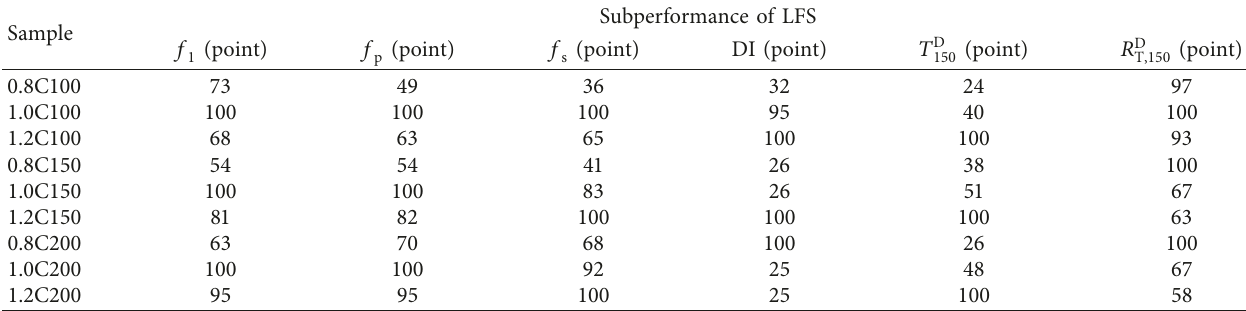
Table 4: Comparative score of the subperformance of LFS based on a full score of 100 points.